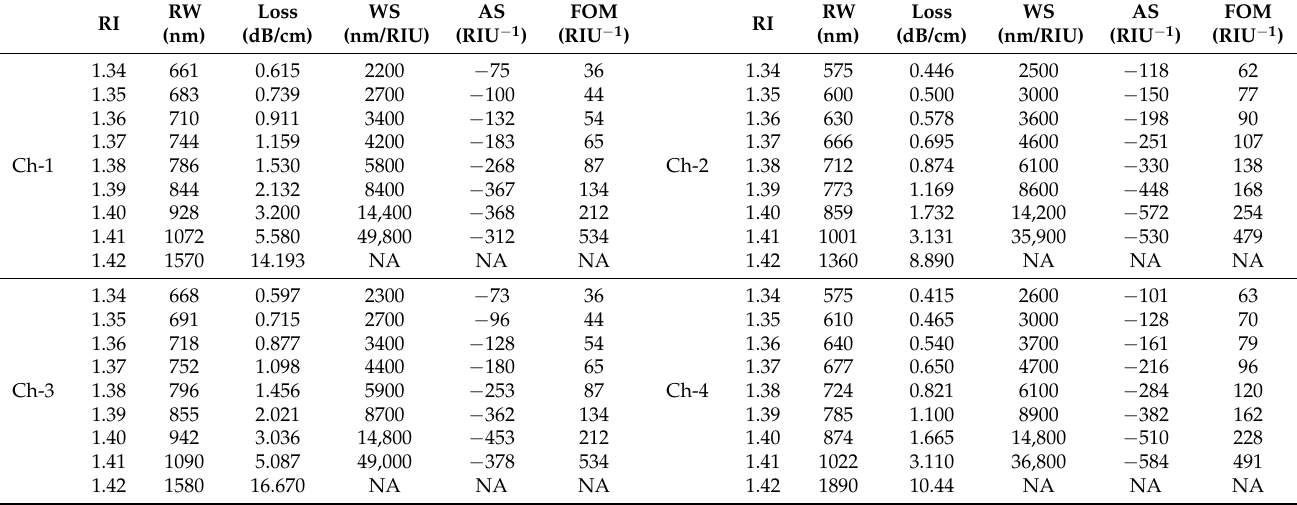
Figure 7. Comprehensive performance analysis of the proposed multichannel sensor. ( a ) Loss curve of each channel; ( b ) AS of each channel; ( c ) FOM and RW fitting curves for each channel. Table 1. Performance analysis of the proposed multi-channel